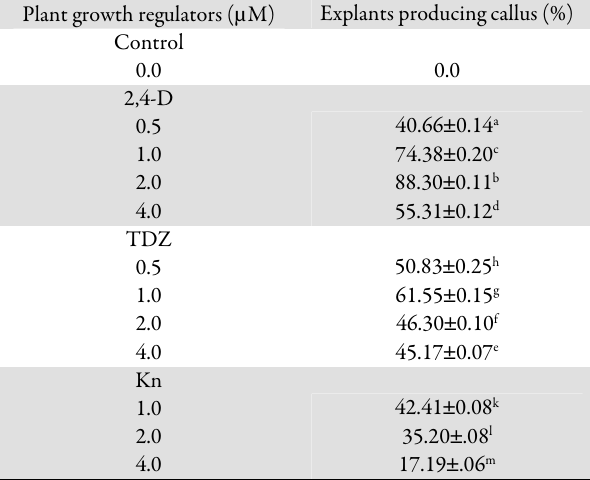
*Observations were made with explants of 0.5 mm thickness in semisolid medium. Each value is the mean of 20 observations taken from two experiments each with three replicates. Mean separation within the different treatments of a particular phytohormone is by Tukey’s multiple range test, p=0.05.